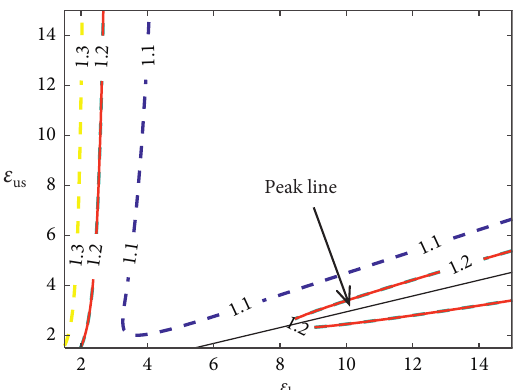
� 0.7, r � 0.9, and ξ � 2 iso